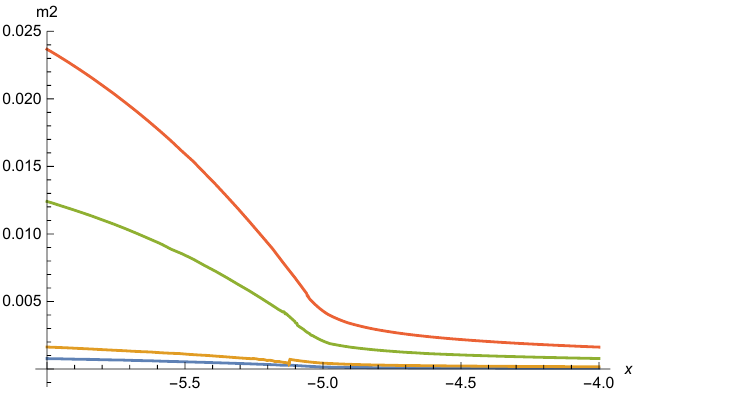
Figure 22. Dimensionless mass term ˜ m 2 = u (cid:48) as function of x = ln ˜ ρ , for ξ ∞ = 0.1 (blue), 1 (orange), 10 3 (green), and 10 4 (red), from bottom to